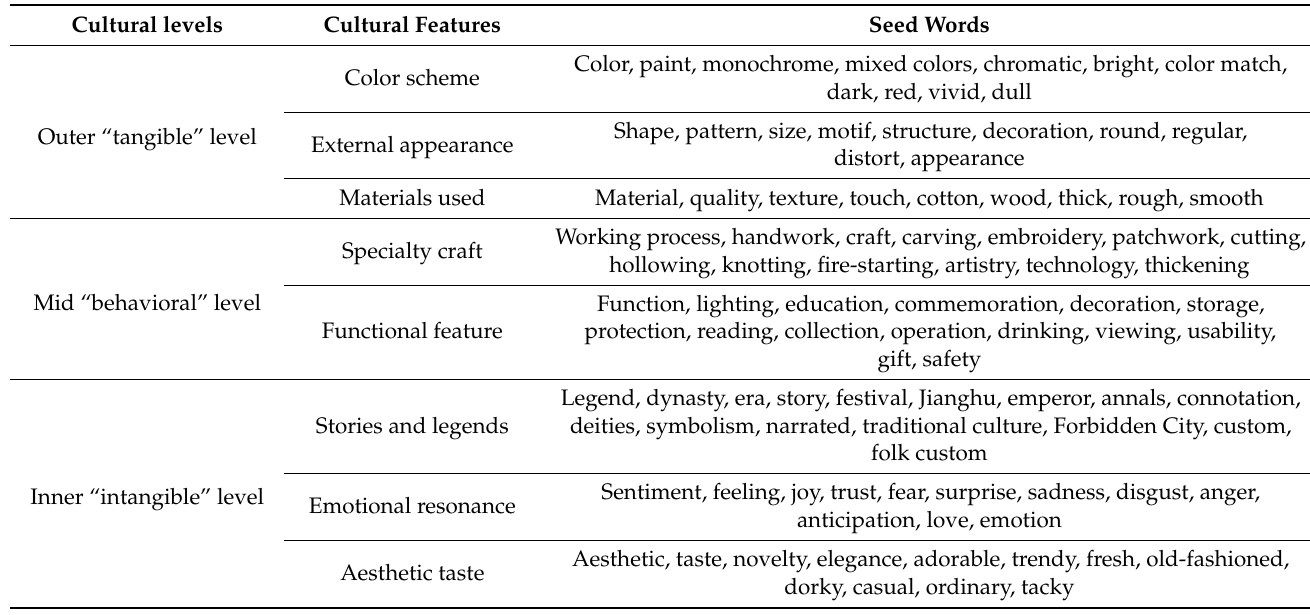
Table 2. Seed words for cultural